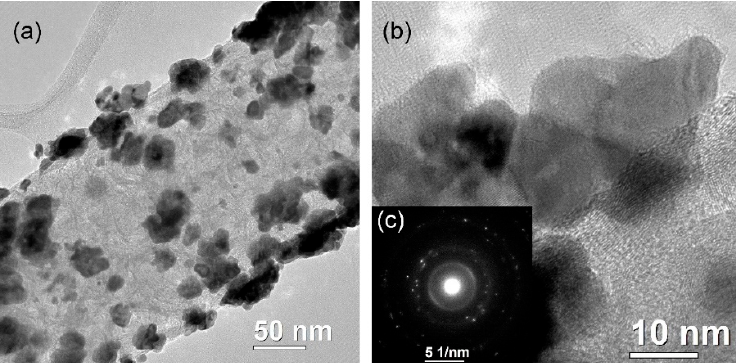
Figure 14. BF TEM images of CNF: ( a ) smooth surface; ( b ) enlarged image of Pt crystals on the surface layer; and ( c ) corresponding SAED pattern for sample 10